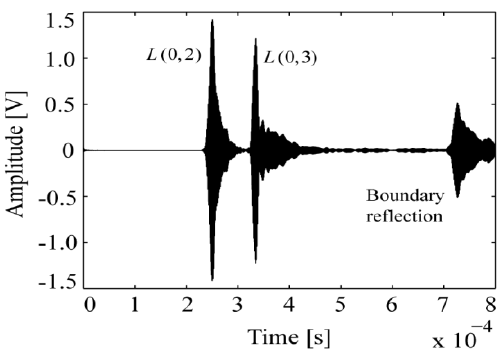
Figure 5. Response signal due to the 12-cycle tone burst excitation at 790 kHz.